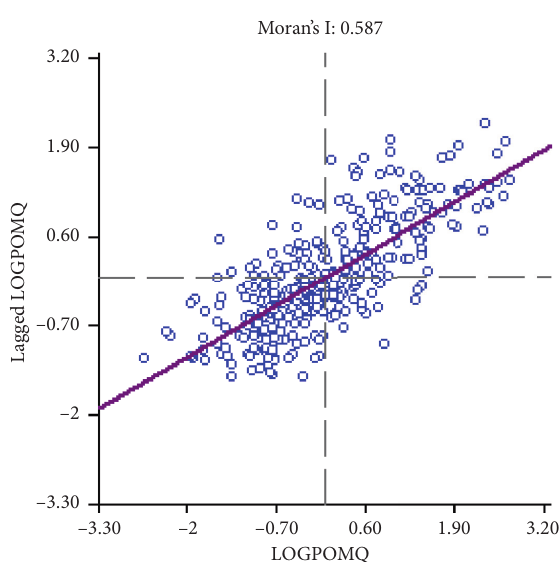
Figure 9: Moran’s Index scatterplot on data points related to log NLP (Euro/m 2 ) (source: authors’